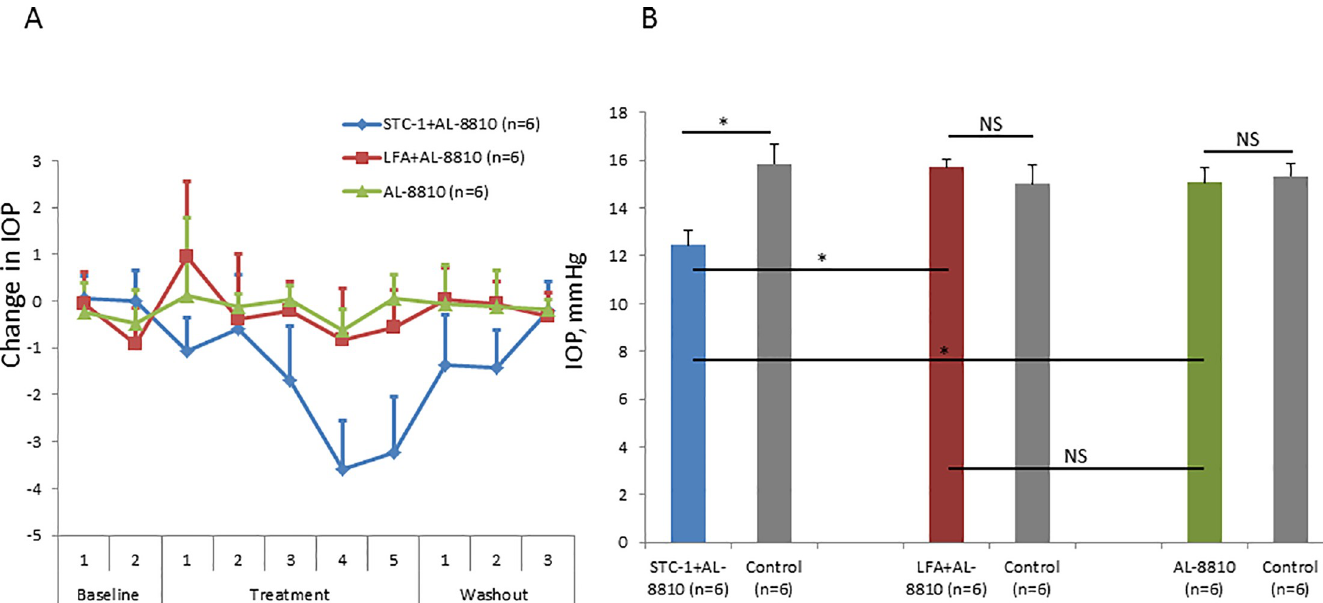
Fig 2. STC-1, but not LFA, reduces IOP in the presence of a pharmacologic inhibitor of the FP receptor in wild-type mice. After baseline IOP measurements, the pharmacologic FP receptor blocker AL-8810 (10 mM) was given alone or in combination with LFA (10 − 4 M) or STC-1 (0.5 μ g/ μ L). A) After pre-treatment baseline IOP measurements, STC-1 + AL-8810 reduced IOP; however, LFA + AL-8810 and AL-8810 alone had minimal effect on IOP. B) At the maximal reduction of IOP with treatment (average of treatment day 4 and 5), STC-1 + AL-8810 significantly reduced IOP compared to the contralateral eye. Neither LFA + AL-8810 or AL8810 alone affected pressure when compared to the contralateral eye. There was a significant IOP difference when comparing STC-1 + AL-8810 and LFA + AL-8810. There was no difference between LFA + AL-8810 and AL-8810 alone. Sample size of all conditions was n = 6. NS = not significant. Error bars represent average ± standard deviation. � P <